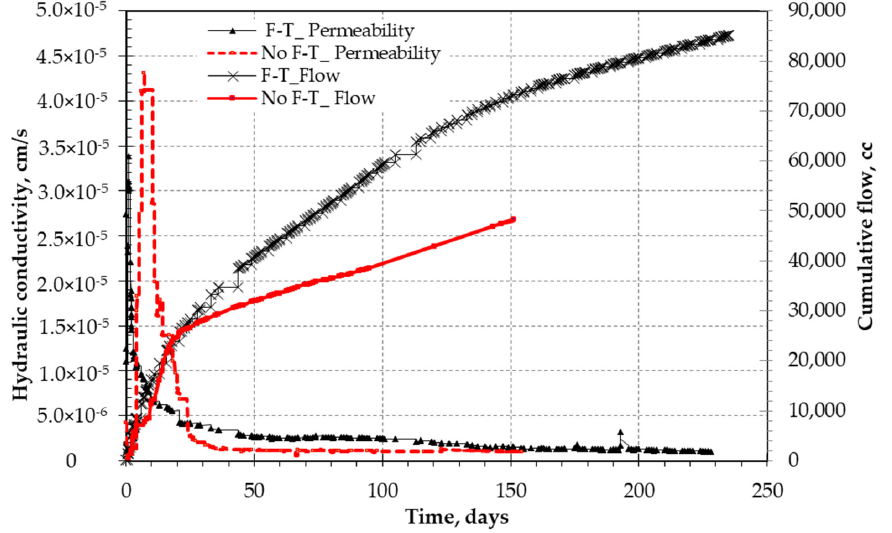
Figure 5. Hydraulic conductivity and cumulative flow for 20%Q before and after freeze-thaw cycles under 7 kPa stress.